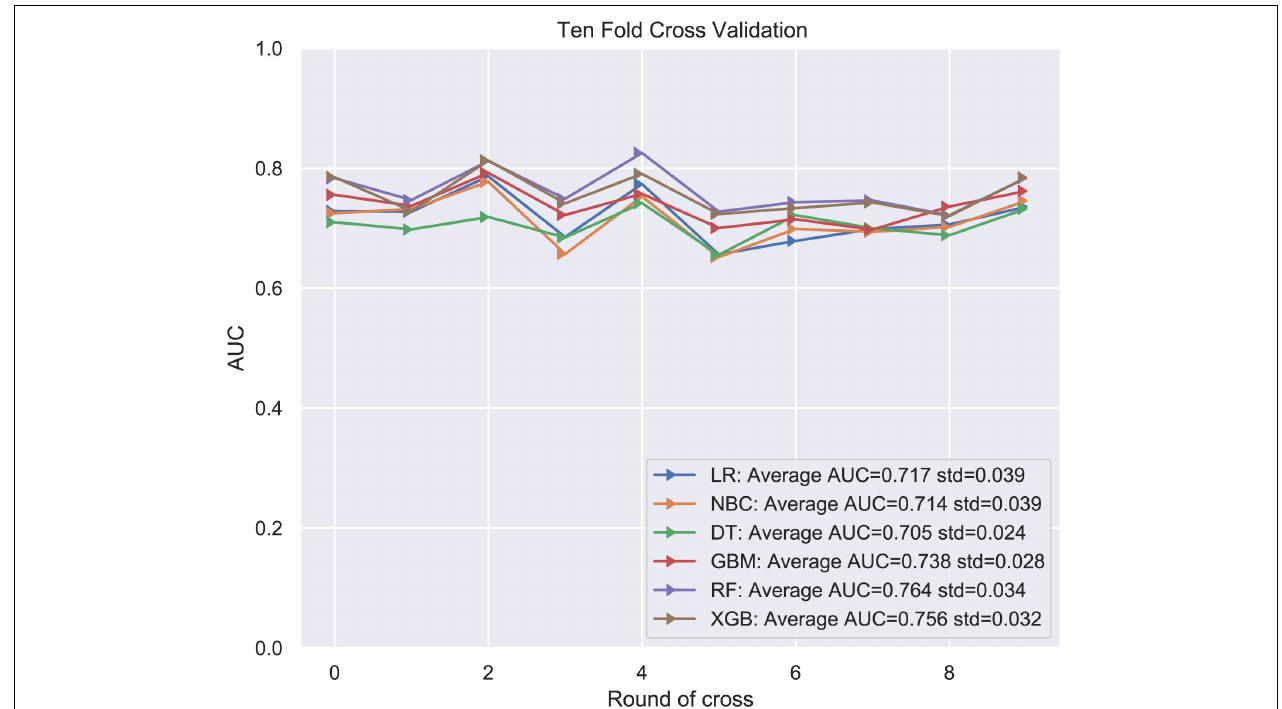
FIGURE 1 | Ten-fold cross-validation of 6 ML algorithms for predicting LNM in patients with ES in the training set.